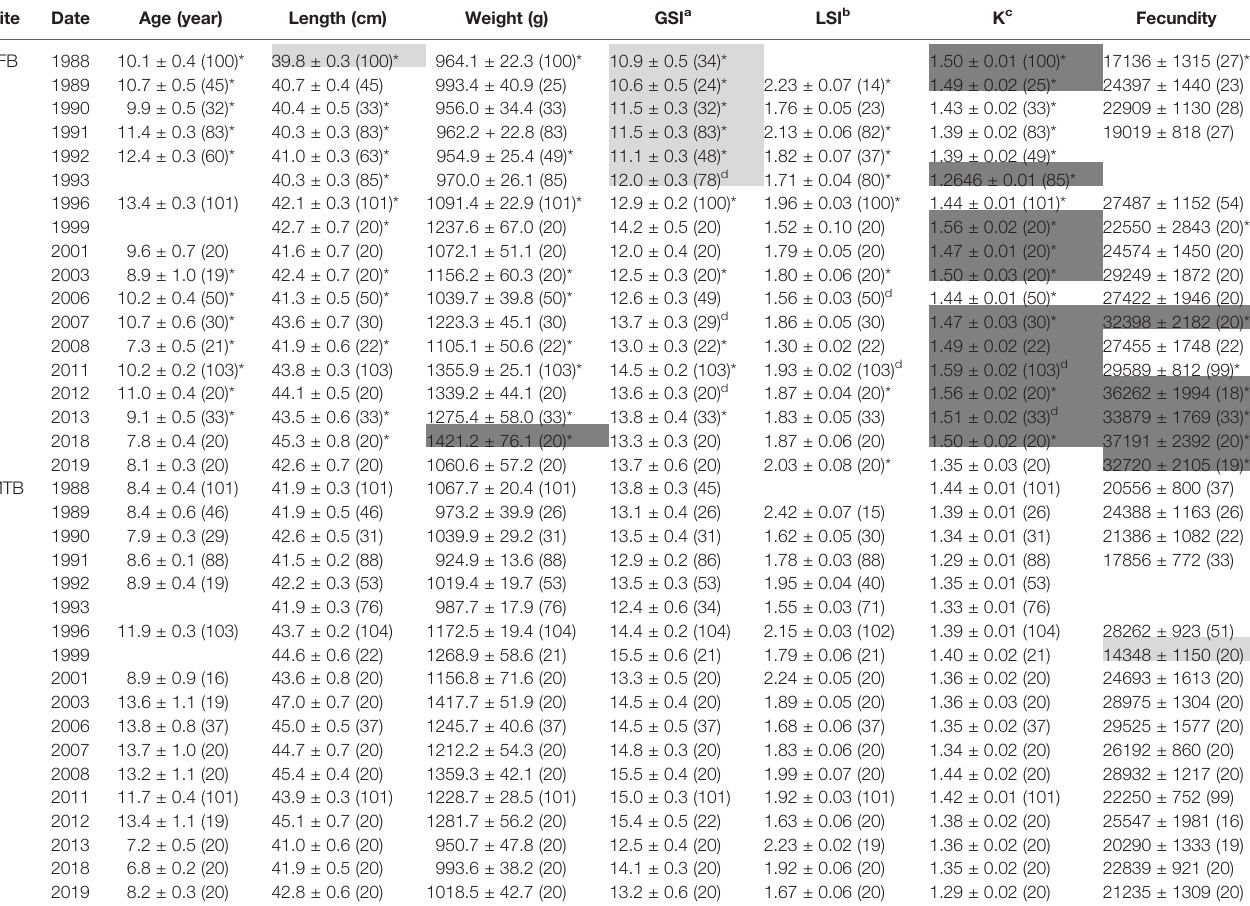
TABLE 3 | Age, length, weight, condition factor (K), gonadosomatic index (GSI), liver somatic index (LSI), and fecundity (total number of eggs) of female white sucker ( Catostomus commersoni ) from Jack fi sh Bay and Mountain Bay, collected during pre-spawning (spring) from 1988 to 2019.